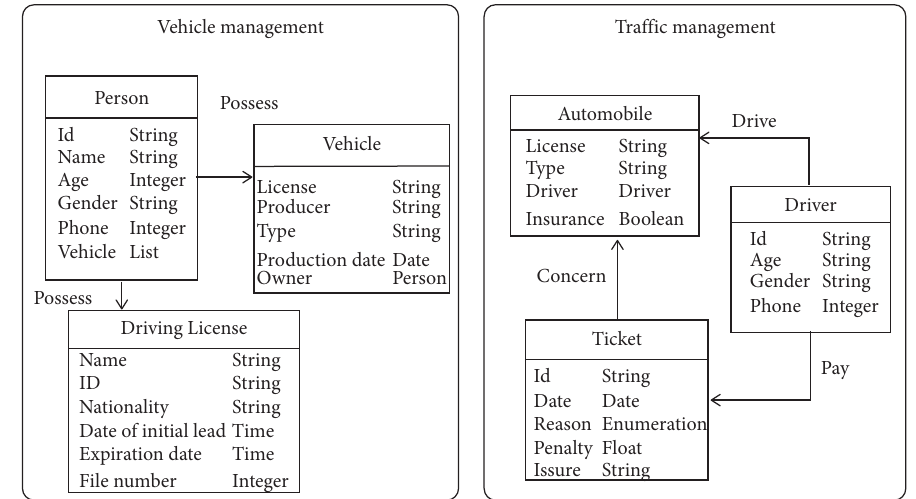
Figure 5: An illustration of the use case. Table 5: Matching between concepts.